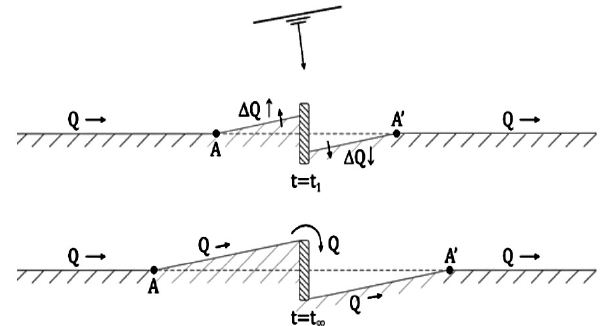
Figure 14. Shoreline change affected by sediment bypassing a groin under oblique